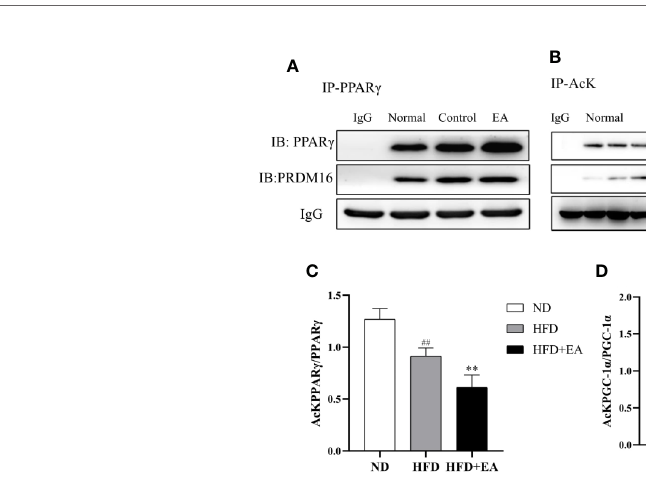
FIGURE 5 | EA treatment facilitated the interaction between PPAR g and PRDM-16 and decreased PPAR g and PGC-1 a acetylation. IWAT tissues from ND, HFD and HFD + EA groups were immunoprecipitated with acetylated lysine (AcK) antibody and immunoblotted with PPAR g and PGC-1 a antibodies. (A) Western blot for Co- IP studies of PPAR g and PRDM16. (B) Acetylation of PPAR g and PGC-1 a in white adipose tissue. The ratios of acetylated PPAR g to PPAR g (C) and acetylated PGC-1 a to PGC-1 a (D) . Data were represented as mean ± SD (n = 3). ## P < 0.01 vs. the ND group; **P < 0.01 vs. the HFD + EA